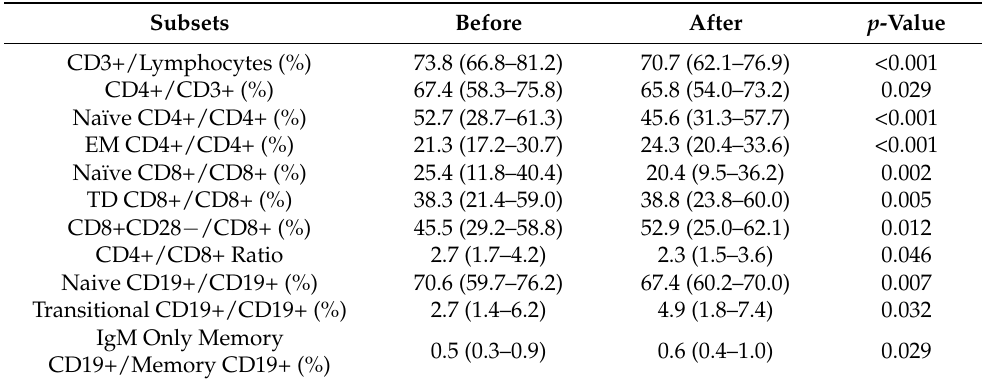
Table 2. Frequency of T and B cell subsets in the lung transplant candidates before and after